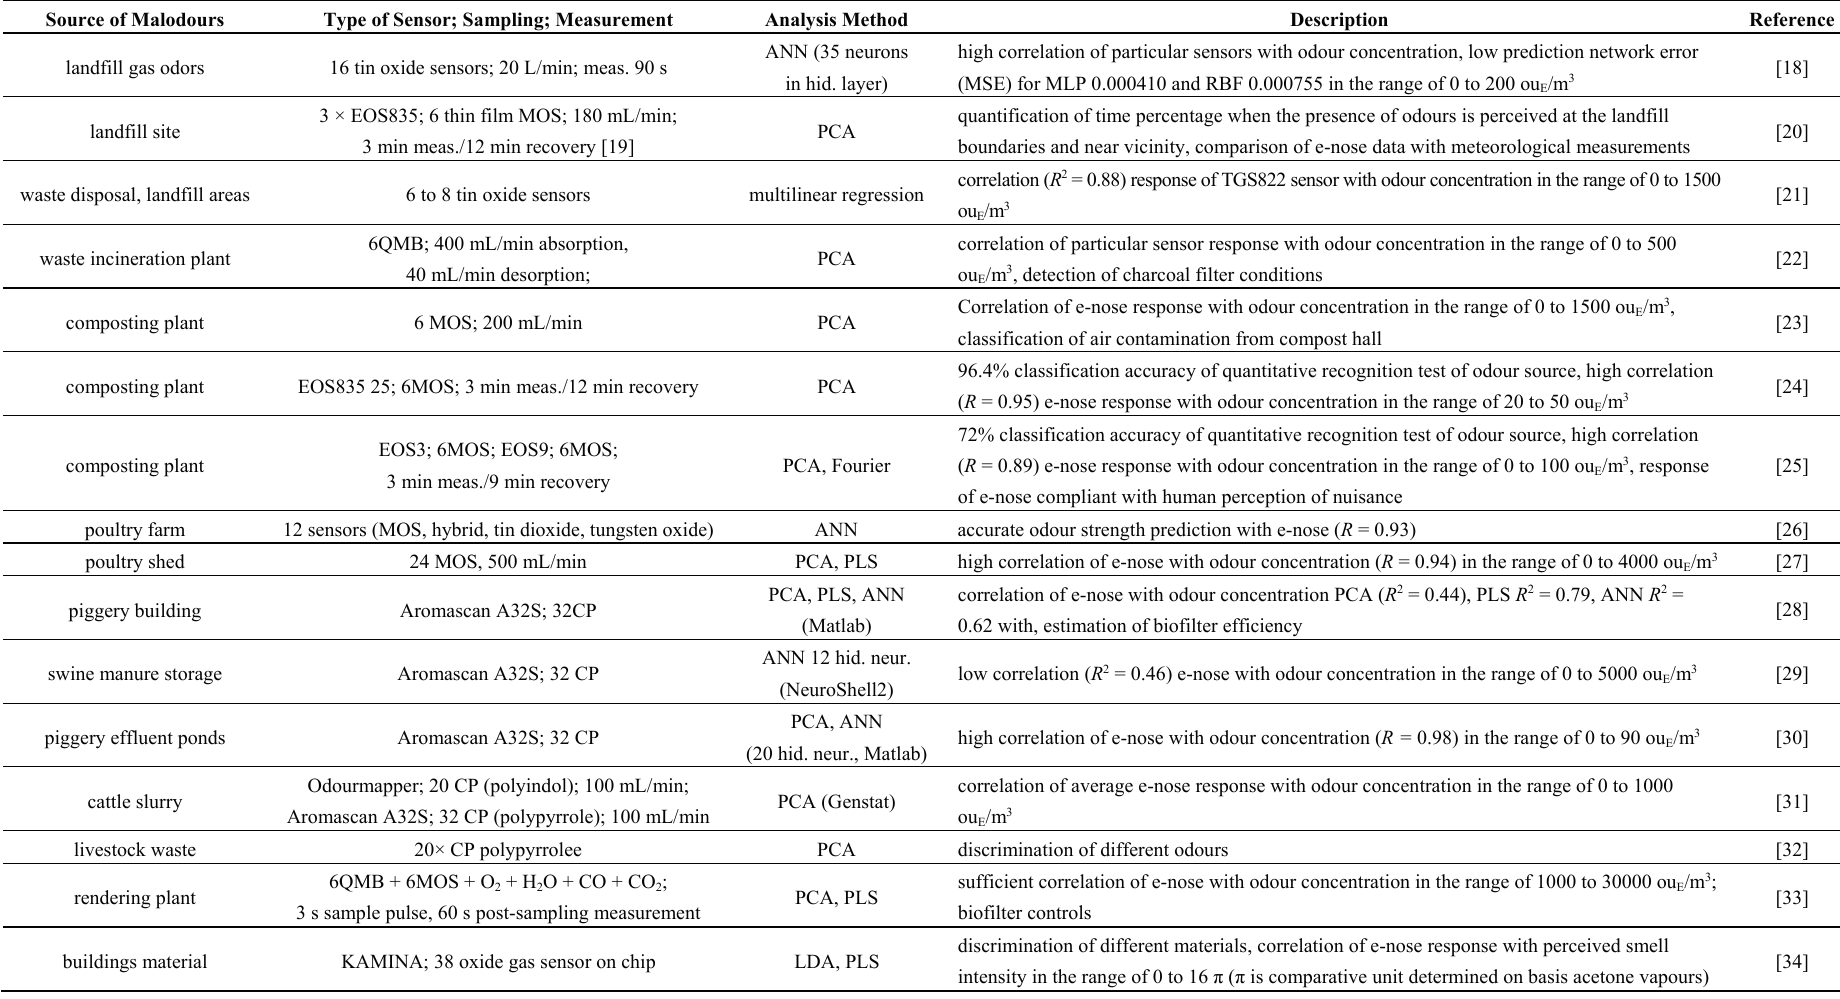
Table 1. Review of environmental sources of air pollution malodour evaluated using